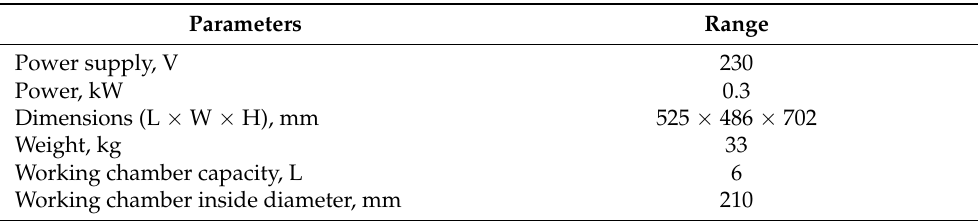
Table 5. Specifications of EC6 type disc finishing machine.